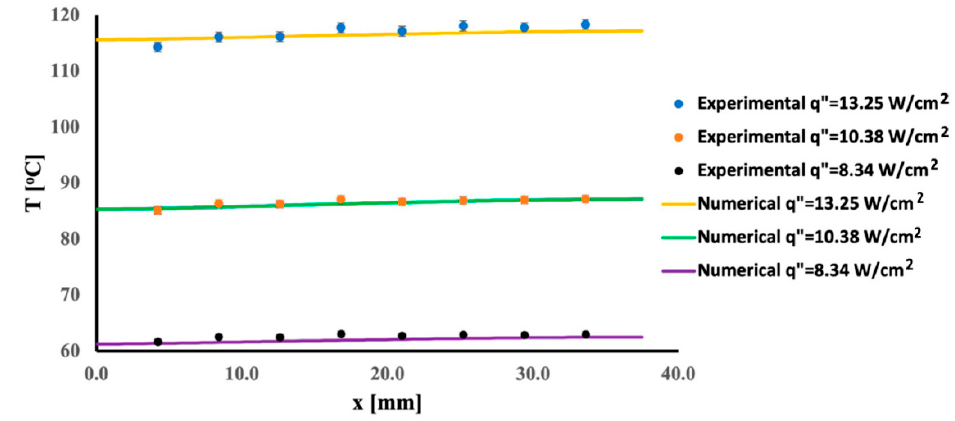
Figure 3. Temperature variation 1 mm below the interface.